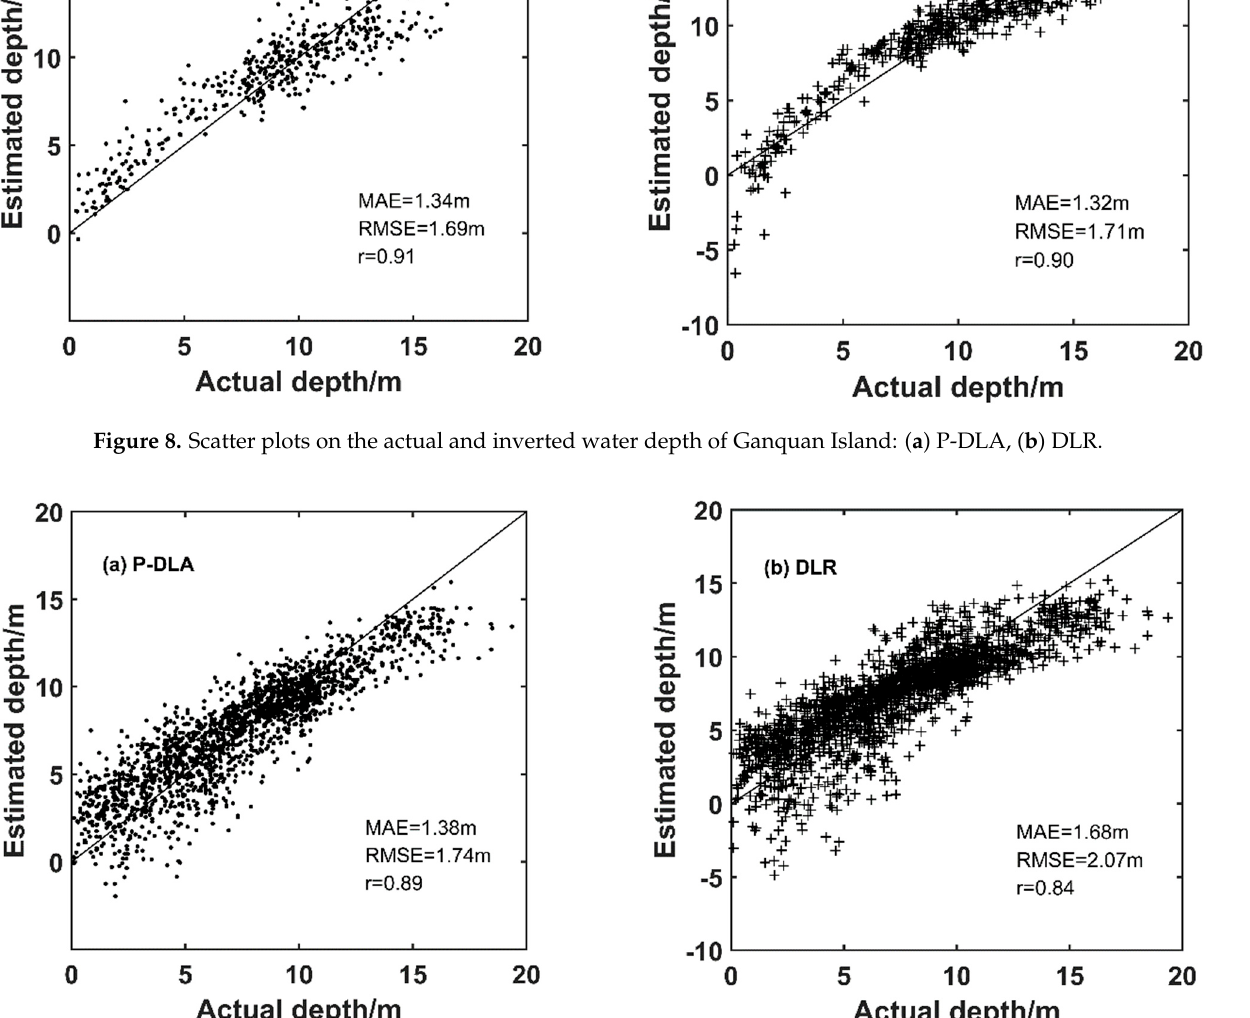
Figure 9. Scatter plots on the actual and inverted water depth of Zhaoshu Island: ( a ) P-DLA, ( b ) DLR.